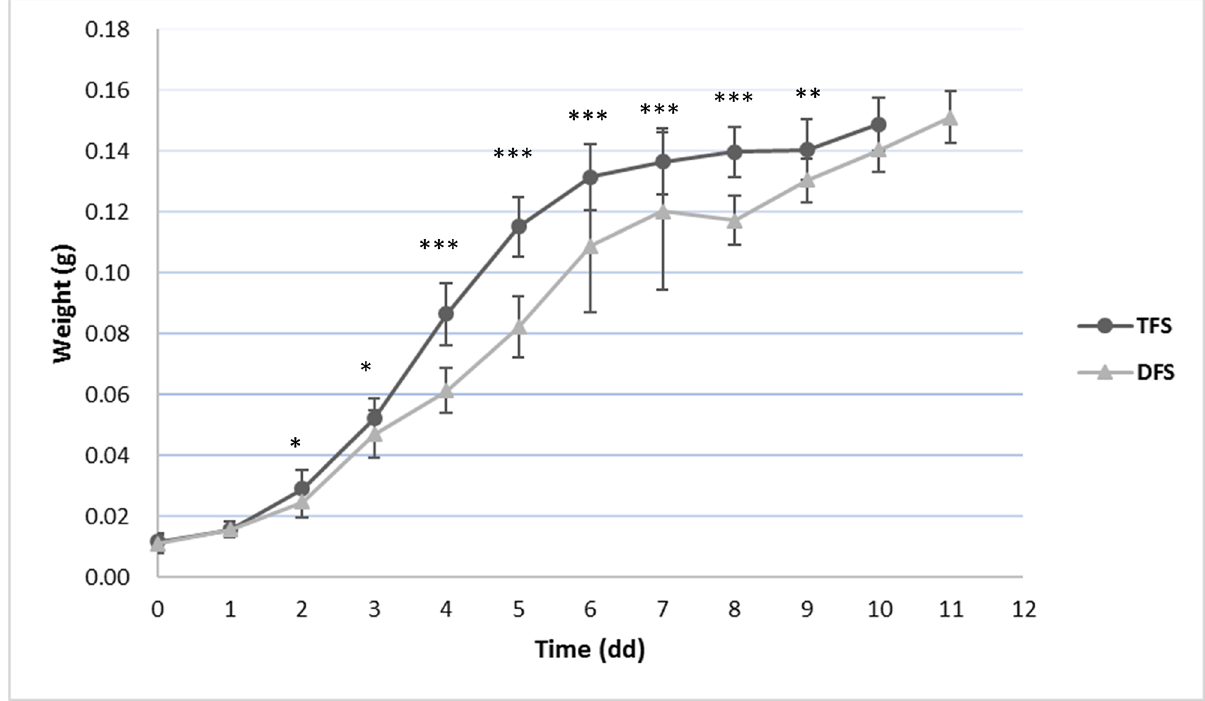
Fig 2. Average weight (mean ± SD) of the BSF larvae reared on two different feeding systems; TFS: Total amount of diet provided at the beginning (480g on WB); DFS: Daily allocated diet (40g/d on WB)). (cid:3) : P (cid:20) 0.05; (cid:3)(cid:3) : P (cid:20) 0.01; (cid:3)(cid:3)(cid:3) : P (cid:20)